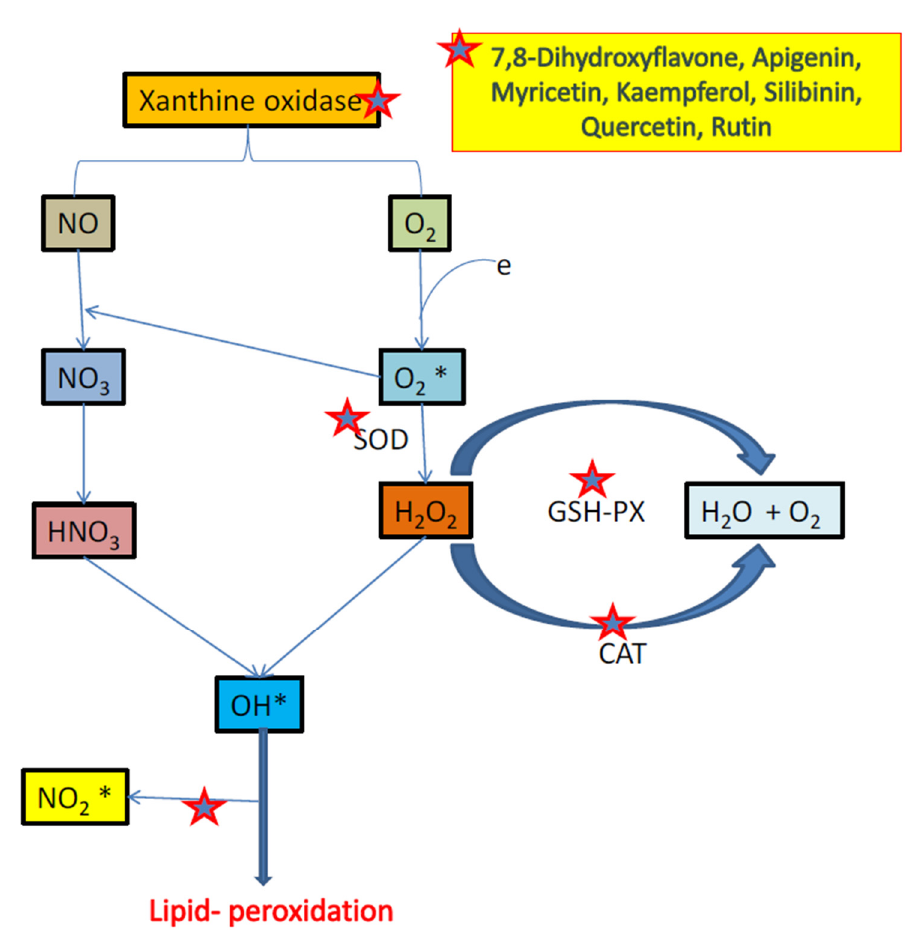
Figure 51. Inhibitory action of flavonoids on Xanthine oxidase pathway . NO, nitric oxide; NO 3 , nitrate; HNO 3 , nitric acid; O 2 , oxygen; O 2 *, oxidative free radical; H 2 O 2 , hydrogen peroxide; SOD, superoxide dismutase; GSH-PX, glutathione peroxidase; CAT, catalase; OH*, hydroxyl free radical; NO 2 *, nitrogen dioxide radical.